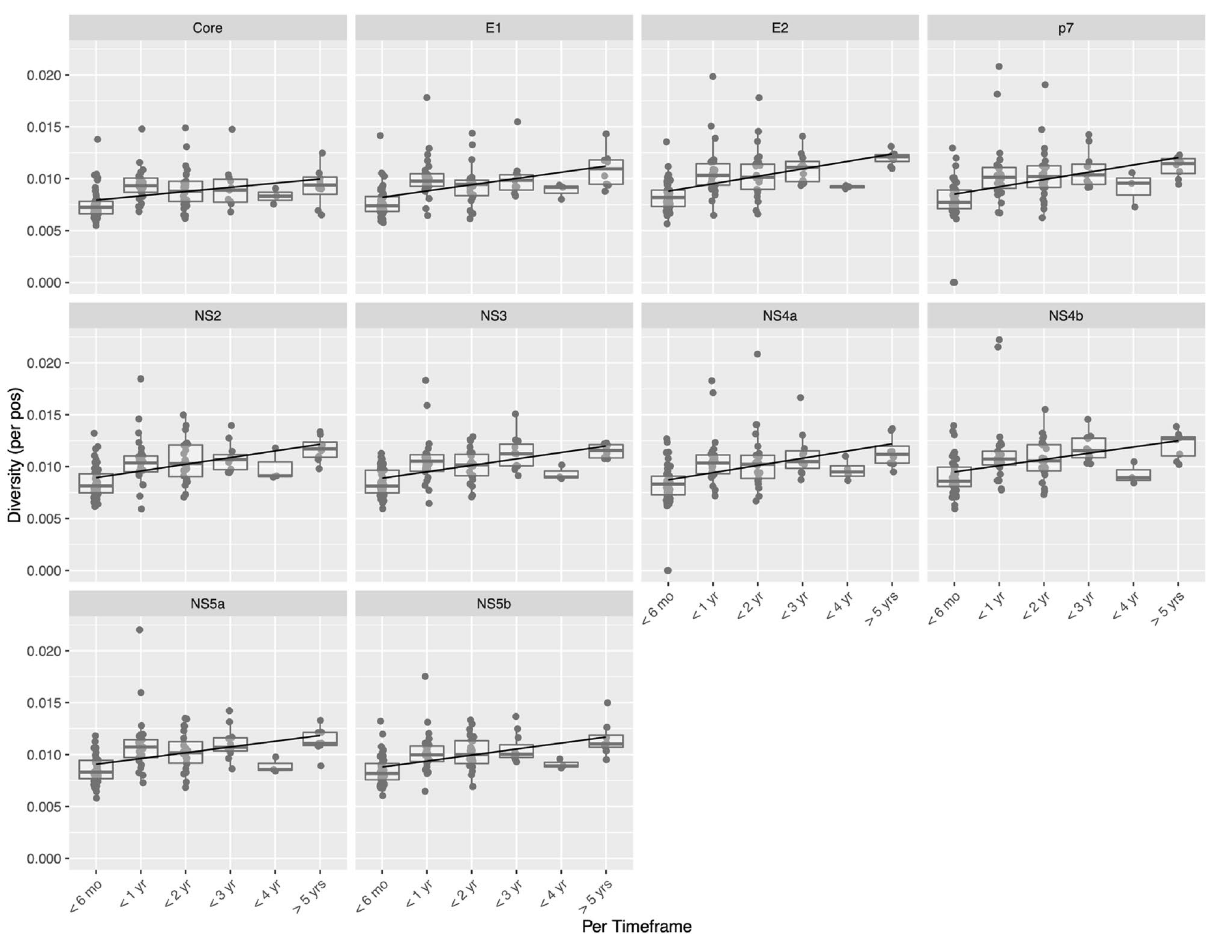
Figure 2. Shannon diversity across the HCV genome and over time. Read depth normalized Shannon diversities for each gene grouped by timeframe of infection: less than 6 months (< 6 mo), between 6 months and 1 year (< 1 yr), between 1 and 2 years (< 2 yr), between 1 and 3 years (< 3 yr), between 3 and 4 years (< 4 yr), and greater than 5 years (> 5